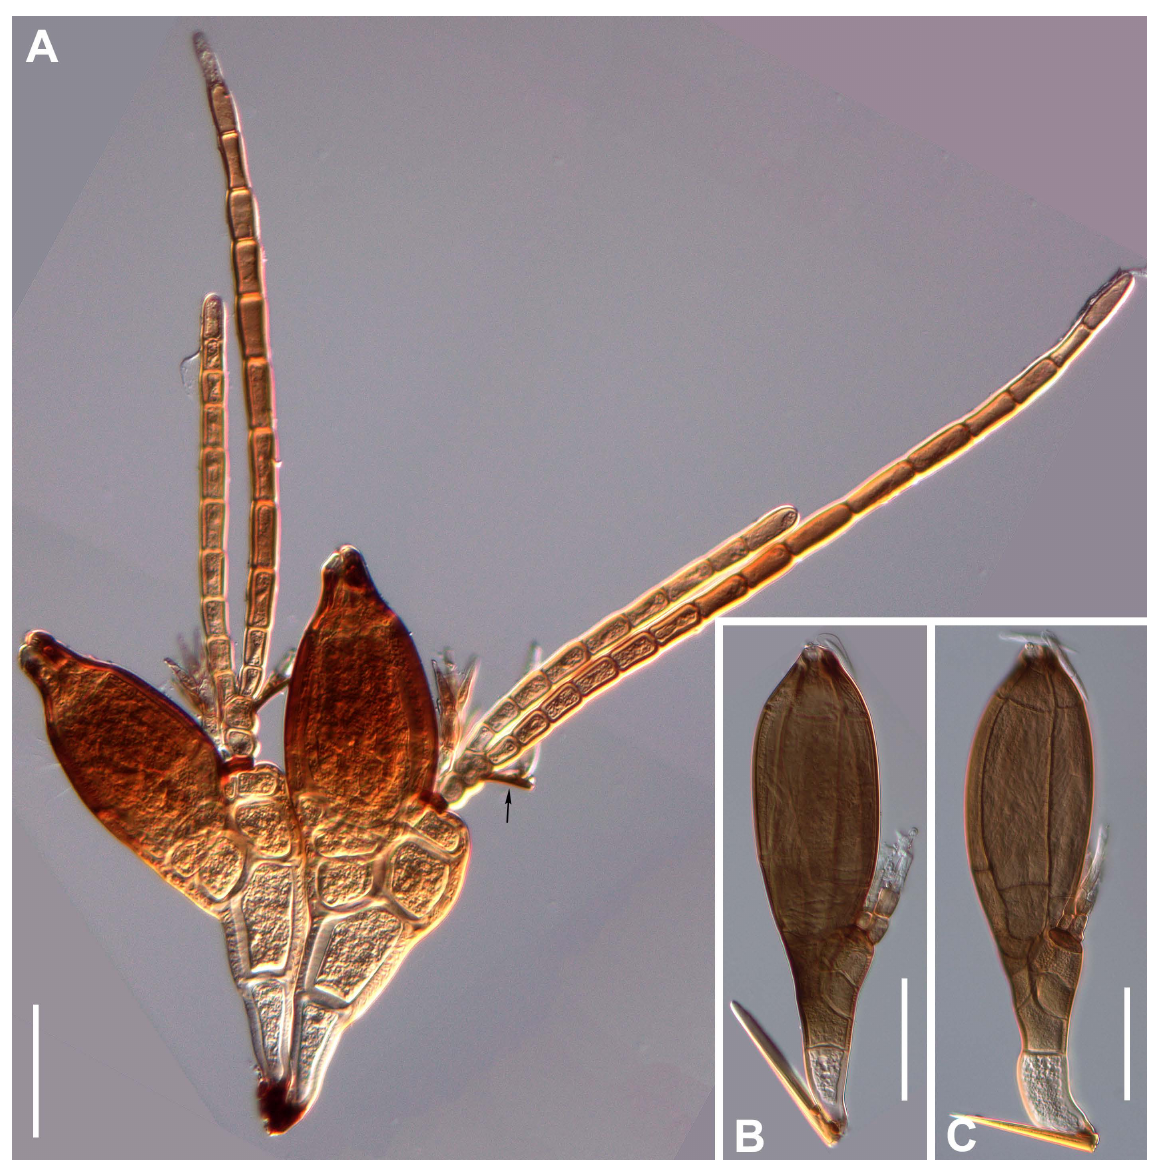
Fig. 29. Laboulbenia spp. A . L. cristata Thaxt. Two mature thalli. – B – C . L. curtipes Thaxt. Mature thalli. Scale bars: 50 µm. Photographs from slides ZMUC C-F-122471 (A), ZMUC